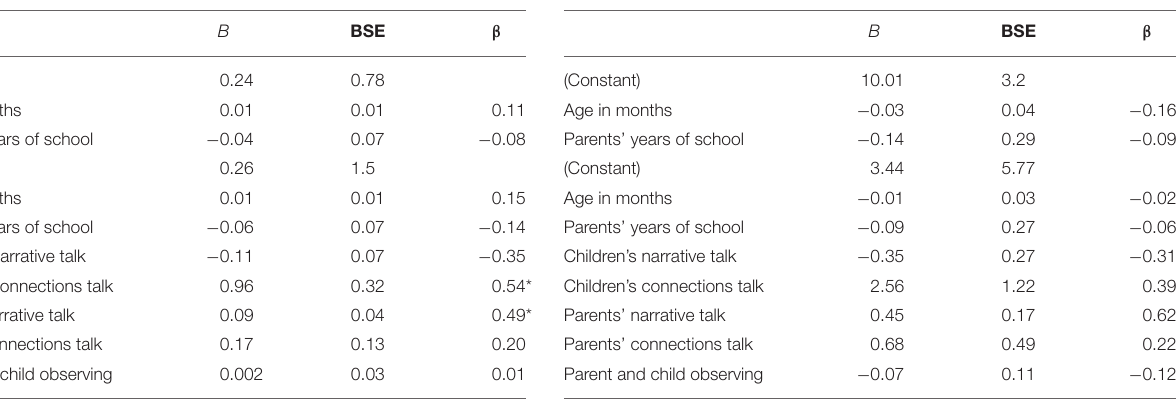
TABLE 6 | Hierarchical regression: predictors of combined parent-and-child explanatory science talk at the fossil and replica bone